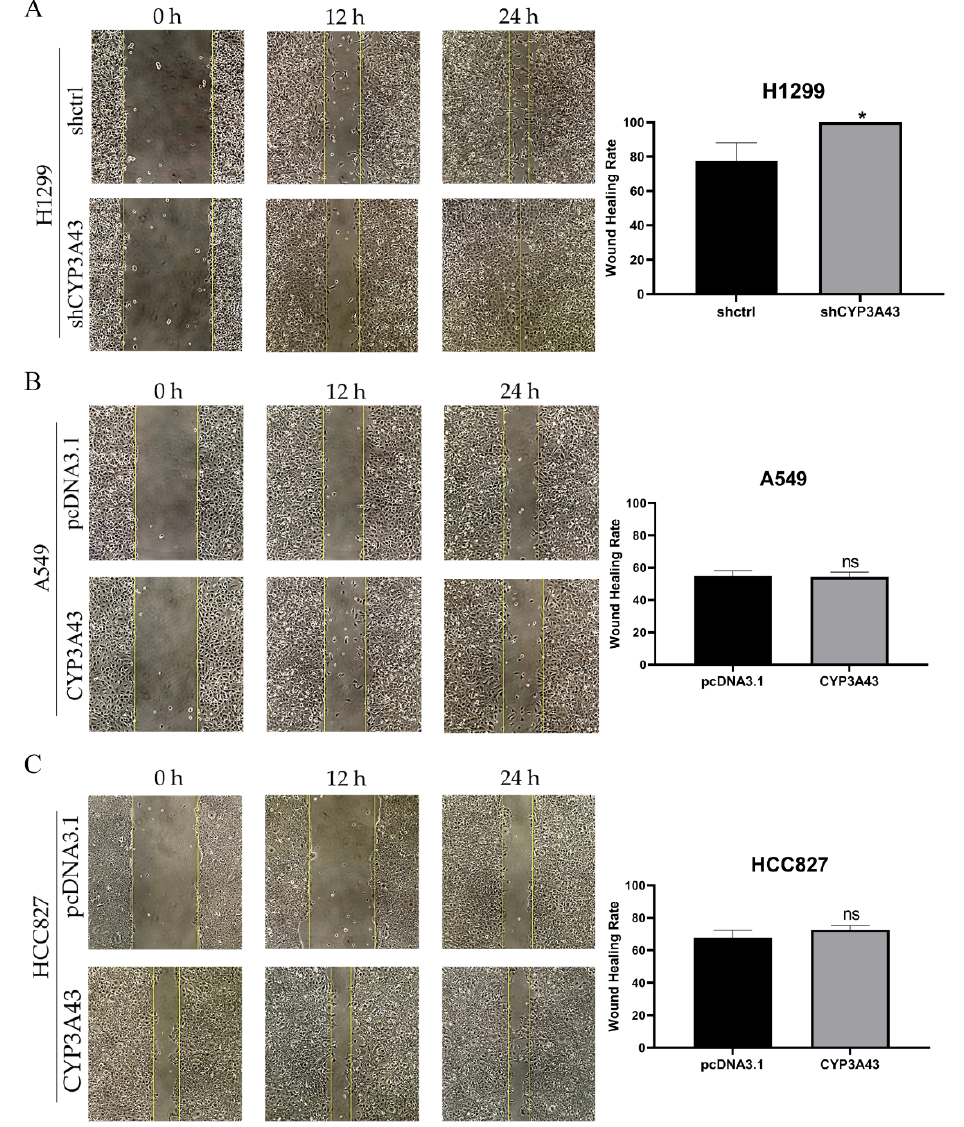
Figure 4. CYP3A43 knockdown promotes the migration ability of H1299 cells. ( A ) The cell migration ability of H1299-shCYP3A43 cells was increased compared to the H1299-shctrl cells. ( B , C ) CYP3A43 overexpression did not affect the migration ability of A549 ( B ) and HCC827 ( C ) cells. The A549 and HCC827 cells were transfected with CYP3A43 plasmids or empty vector for 24 h, and then a wound healing assay was performed. The results are shown as the mean ± SD, n = 3. *, p < 0.05; ns, p > 0.05.